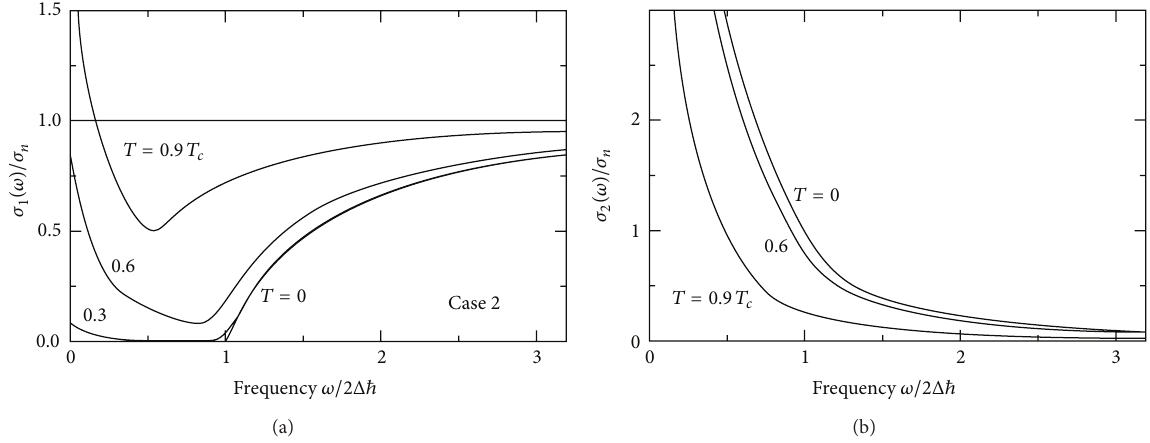
Figure 5: Frequency dependence of the conductivity of a superconductor at different temperatures 𝑇 relative to the transition temperature 𝑇 𝑐 . (a) The real part 𝜎 1 (𝜔)/𝜎 𝑛 exhibits a sharp drop at the superconducting gap 2Δ and vanishes below for 𝑇 = 0 . For finite temperatures, the gap gradually moves to lower frequencies; in addition a finite conductivity emerges at low frequencies that increases considerably as 𝑇 → 𝑇 𝑐 ; 𝜎 1 even exceeds the normal state conductivity in a narrow frequency range right below 𝑇 𝑐 . (b) The imaginary part of the conductivity 𝜎 2 (𝜔)/𝜎 𝑛 diverges for low temperatures as 𝜎 2 (𝜔) ∝ 𝜔 −1 . The kink of 𝜎 1 (𝜔) at 𝜔 = 2Δ/ℏ also shows up in the imaginary part 𝜎 2 (𝜔)